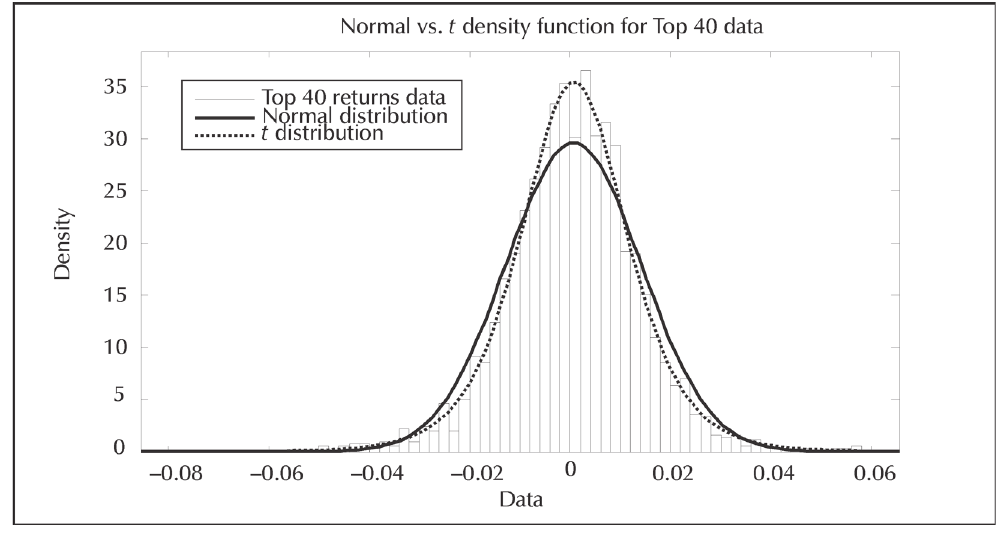
Histogram of Top 40 returns with normal and t distributions fitted